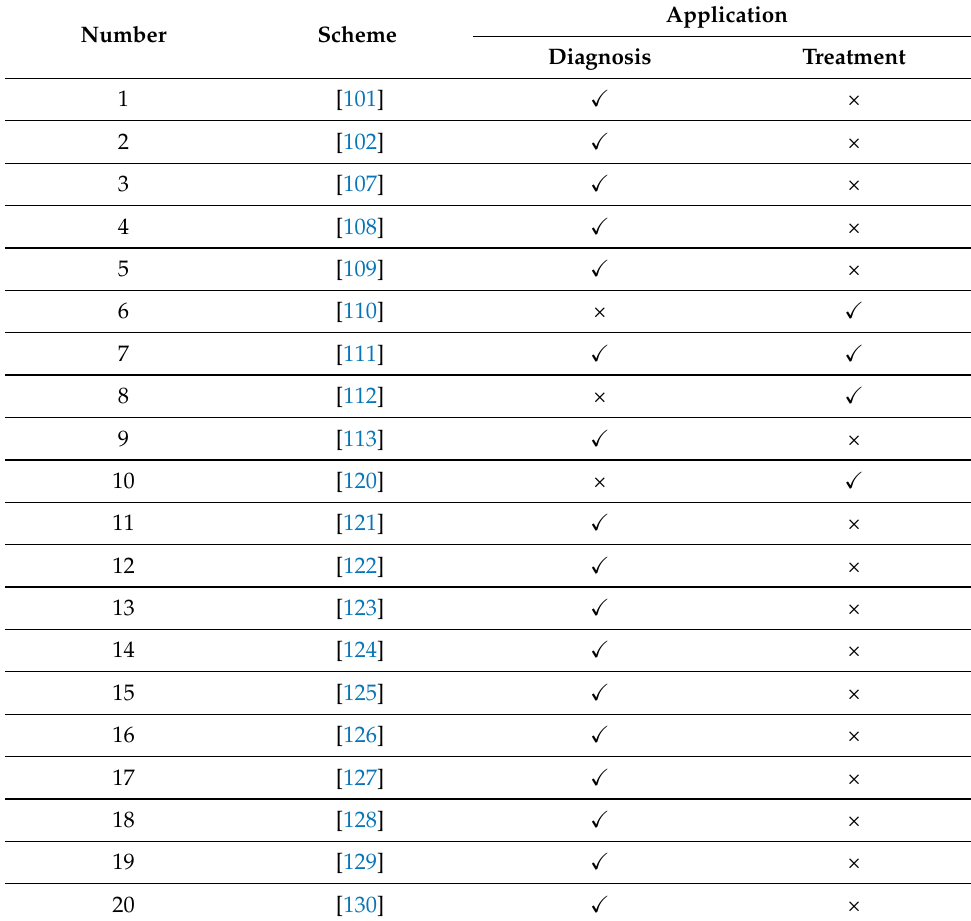
Table 19. Classification of ML-based methods in terms of various